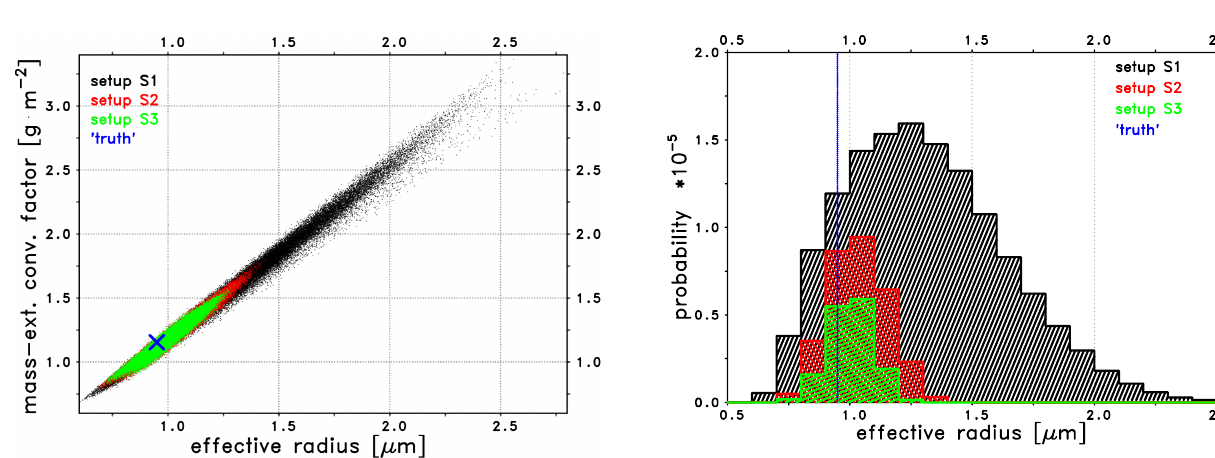
Figure 3. Mass-extinction conversion factor, η , at λ = 532nm as a function of effective radius, r eff , of the solution ensembles for the three lidar setups. The properties of the input ensemble (“truth”) are denoted with a blue cross.